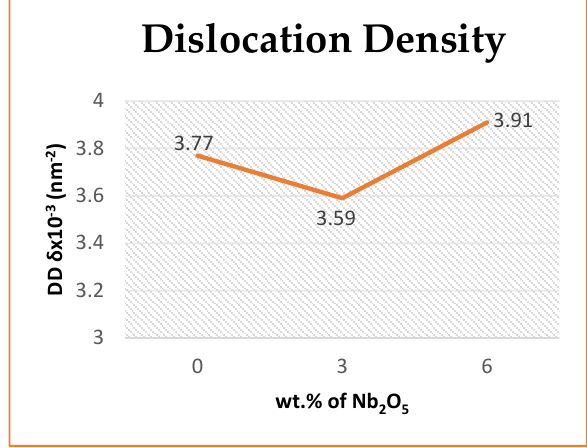
Figure 8. The graph shows the dislocation density.